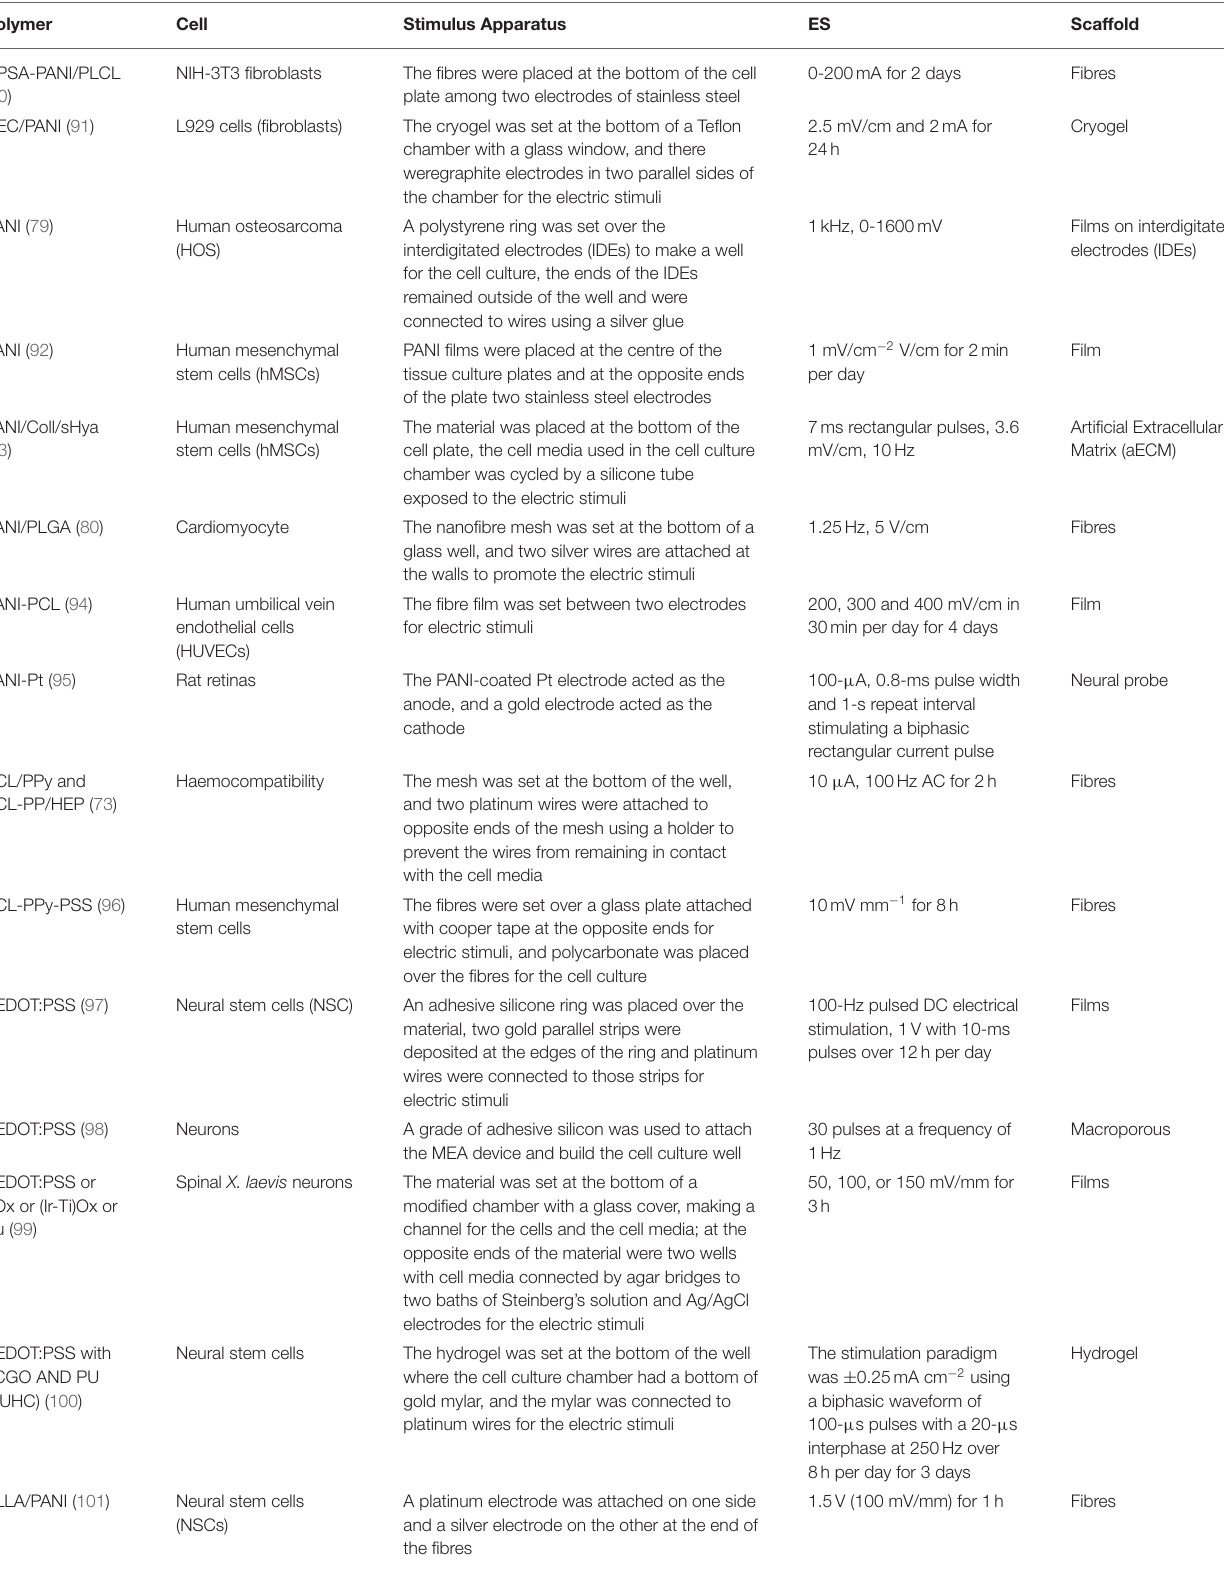
TABLE 2 | Electrical stimulation (ES) studies on different cell lines applied to conductive polymeric materials.